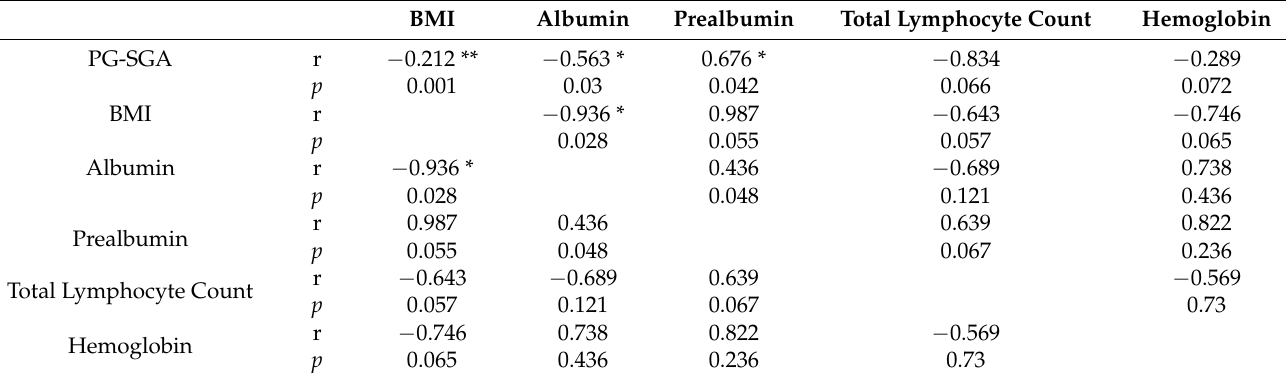
Table 4. The correlation between PG-SGA, body mass index (BMI), and biomarkers.